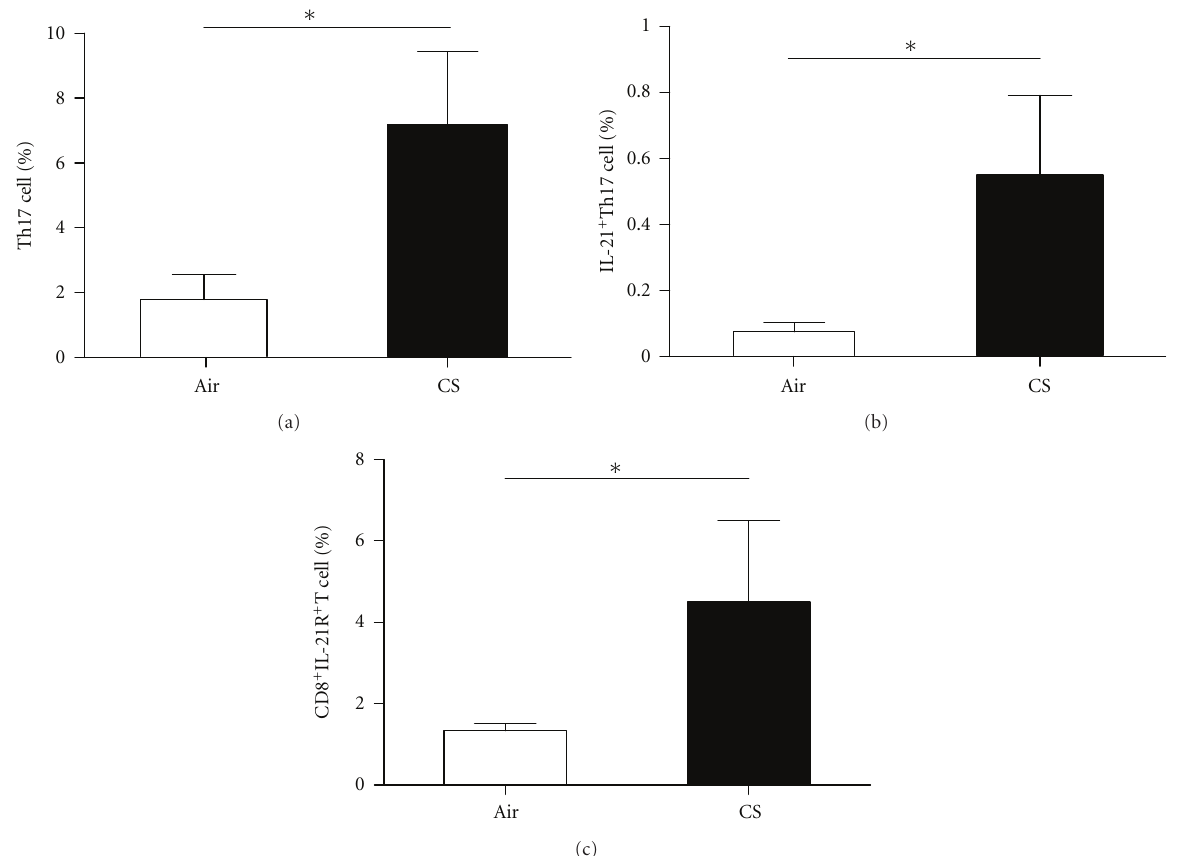
Figure 5: The frequencies of CD4 + IL-17 + (Th17) cells, IL-21 + Th17 cells, and CD8 + IL-21R + T cells in lungs were measured by using flow cytometry. The frequencies (%) of CD4 + IL-17 + (Th17) cells (a), IL-21 + Th17 cells (b), and CD8 + IL-21R + T cells (c) increased in lungs of CS-exposed mice compared with air-exposed mice. Results are expressed as % (mean ± SD). n = 10 animals/group; ∗ P < 0 .